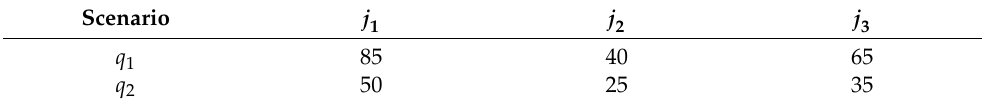
Table 3. The number of rescue materials needed after the accident in different scenarios (items).